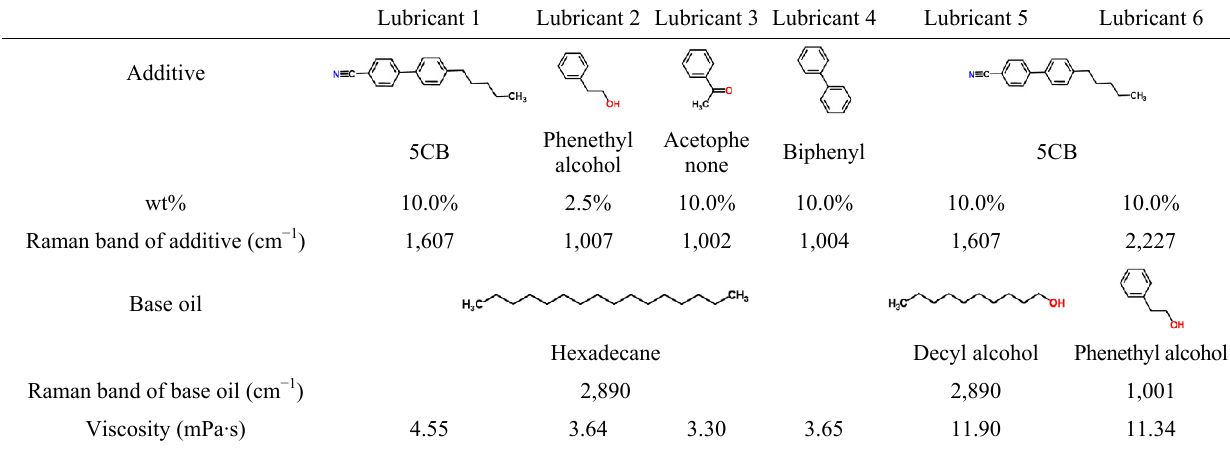
Table 1 The composition of six lubricants and their viscosities.